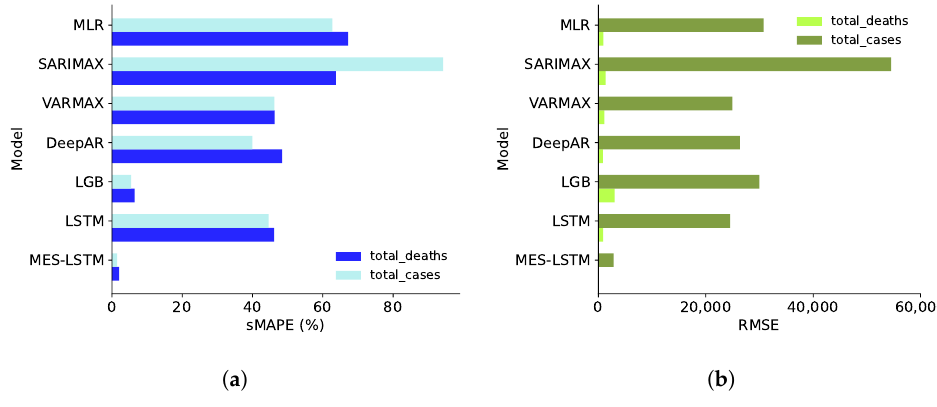
Figure 3. Forecast Accuracy in the SADC Region. ( a ) sMAPE. ( b ) RMSE.